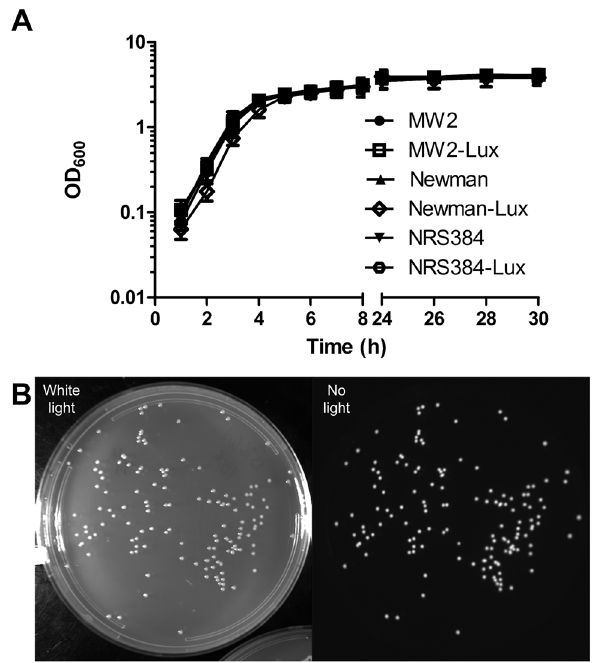
Figure 3. Analysis of invitro growth. A) In vitro growth curves. Strains were grown overnight in TSB with (luminescent strains) or without (parental strains) 10 m g/ml chloramphenicol and subcultured at a dilution of 1:100 in TSB without antibiotic. MW2-Lux, SAP227; Newman-Lux, SAP229; NRS384-Lux, SAP231. B) Luminescence after in vitro outgrowth. SAP231 was grown in TSB and subcultured three times over the course of 48 h. Serial dilutions were plated on TSA in the absence of antibiotics, and plates were imaged as described in Materials and Methods.